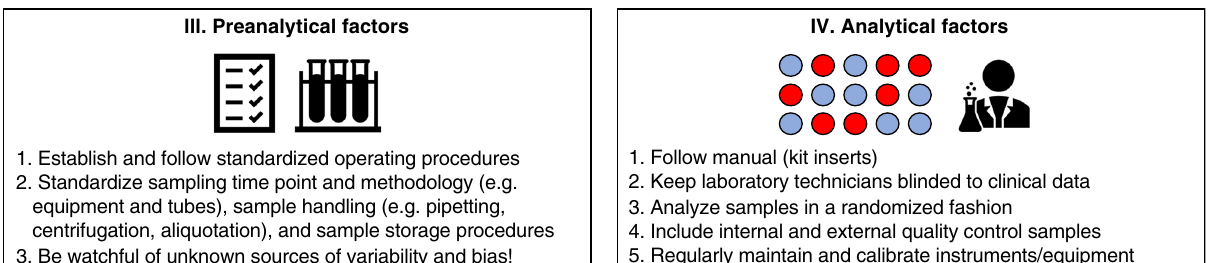
Fig. 1 Finding reproducible biomarkers, from cohort recruitment to biomarker measurements. A fl owchart highlighting key points described in the review, with examples of key factors that in fl uence reproducibility from the fi rst design of the study, up to biomarker measurements.